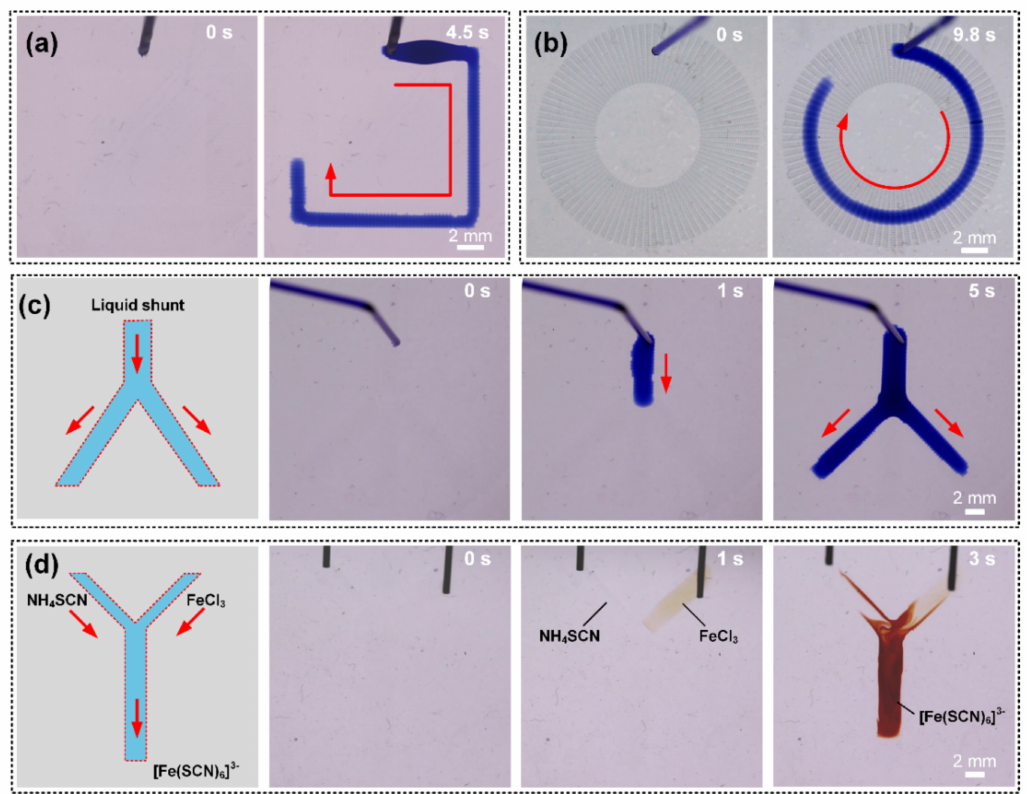
Figure 8. ( a , b ) Continuous unidirectional water transportation along predetermined rectangular and circular liquid motion trajectory. ( c ) Liquid shunt in Y-shaped branch channel. ( d ) Microreactor was performed between FeCl 3 solution and NH 4 SCN